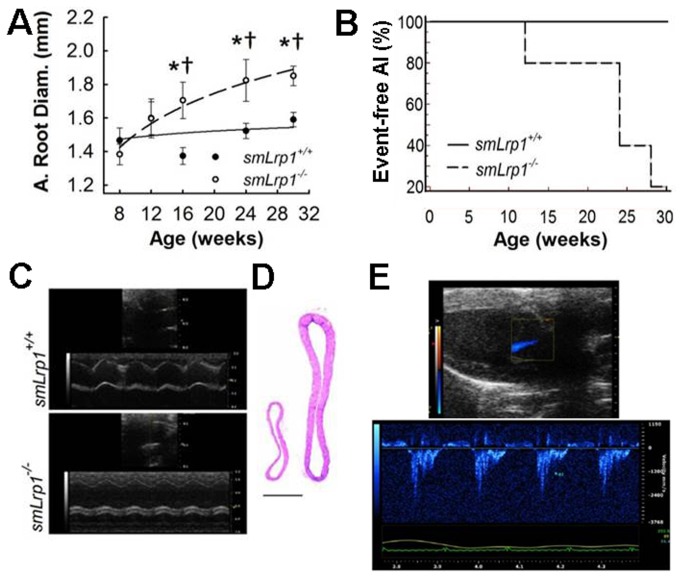
Aortic root diameter and aortic insufficiency.
A, Changes in aortic root diameter during the 22 week study period were measured with echocardiograms at indicated intervals. *P<0.01, versus aortic root diameter of eight week old smLrp1
-/- mice; †P<0.05, pair wise comparison among age-matched smLrp1
+/+ mice. B, Kaplan Meier curve analysis of aortic insufficiency events in smLrp1
-/- and smLrp1
+/+ littermates (P=0.05). n = 6 mice per genotype. C, Representative 2D image of aortic root with M-mode imaging at 16 weeks of smLrp1
-/- (bottom) and wildtype littermate (top). D, Hematoxylin-eosin-stained, cross-section of ascending aorta at ~3mm from aortic valve from 40-week old smLrp1
+/+ (left) and smLrp1
-/- (right) Scale bar, 500μm. E, Detection of AI jet (blue) in 2D long axis image with color Doppler on a 24 week old smLrp1
-/- mouse with the same AI jet projected along pulsed Doppler M-mode.